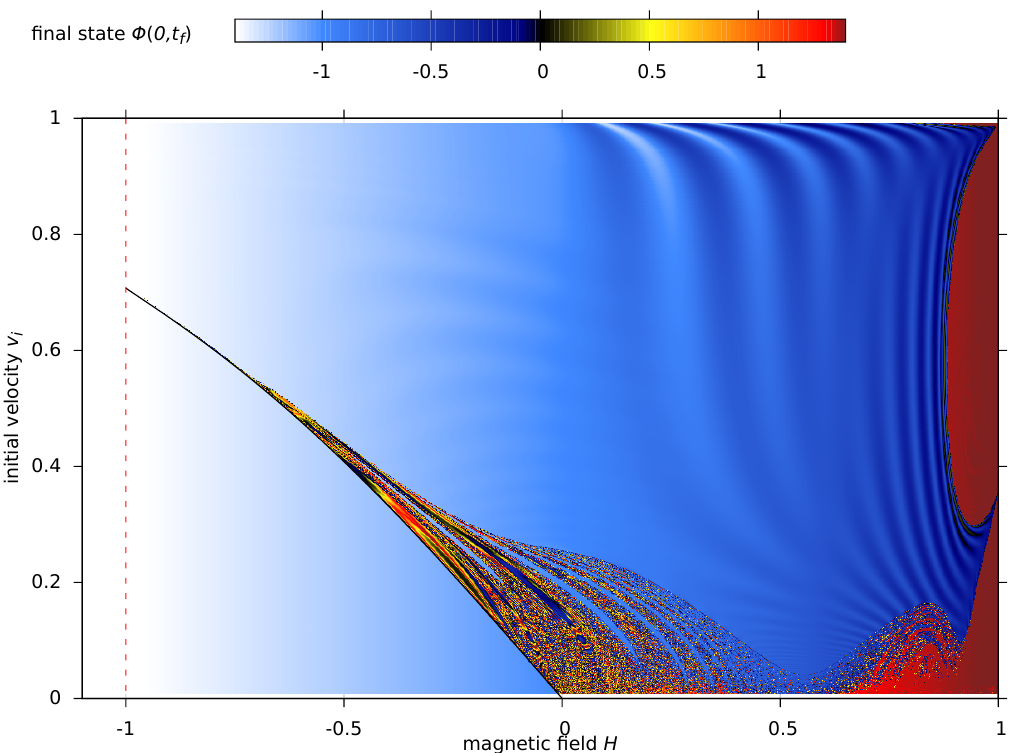
Figure 3 . A ‘phase diagram’ of antikink-boundary collisions. The plot shows the value of the (cid:12)eld at x = 0 a time t f = j x 0 j =v i + 100 after the start of the simulation, as function of the boundary magnetic (cid:12)eld H and the initial velocity v i